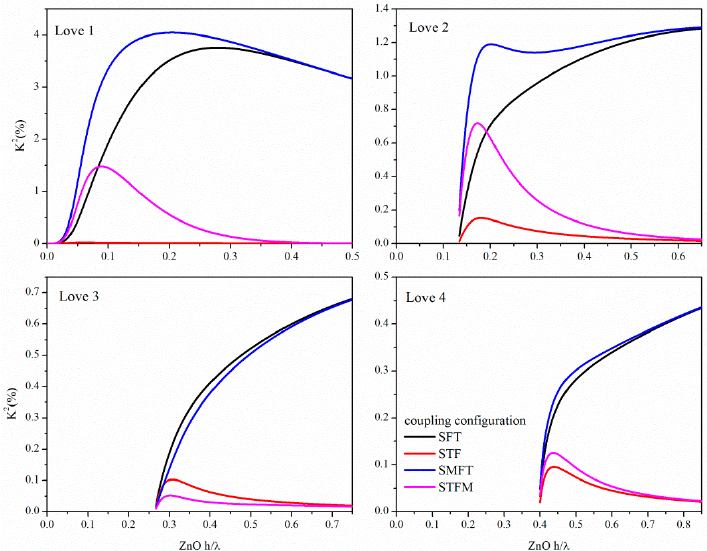
Figure 8. The K 2 dispersion curves of the four coupling configurations calculated for the first four Love modes propagating along 90° tilted ZnO film onto BN substrate.